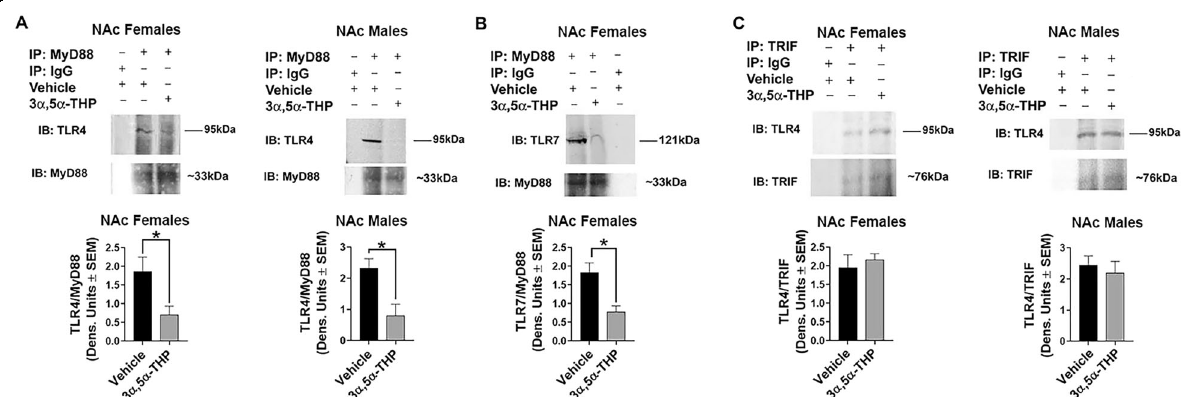
Fig. 3 3 α ,5 α -THP inhibits MyD88, but not TRIF binding to TLRs. Protein extracts obtained from the NAc of male and female P rats ( n = 3 – 4/grp) after administration of 3 α ,5 α -THP (15 mg/kg) or vehicle (45% w/v 2-hydroxypropyl- β -cyclodextrin) were immunoprecipitated (IP) with antibody to MyD88 ( A , B ) or TRIF ( C ). Proteins immunoprecipitated with MyD88 antibody were analyzed by immunoblotting (IB) with TLR4 and MyD88 antibodies ( A ) and TLR7 and MyD88 antibodies ( B ). Proteins immunoprecipitated with TRIF antibody were analyzed by immunoblotting with TLR4 and TRIF antibodies ( C ). Normal IgG was used as immunoprecipitation control. MyD88 co-precipitated with TLR4 ( A ) and TLR7 ( B ), and TRIF co-precipitated with TLR4 ( C ) but MyD88 and TRIF did not co-precipitate with normal IgG ( A – C ). A The levels of TLR4 co-precipitating with MyD88 were signi fi cantly reduced by 3 α ,5 α -THP both in males ( n = 3/grp) and females ( n = 4/grp) ( t -test, * p < 0.05). B The levels of TLR7 co-precipitating with MyD88 were also signi fi cantly reduced by 3 α ,5 α -THP in females ( t -test, * p < 0.05, n = 3/grp). C The levels of TLR4 co-precipitating with TRIF were not altered by 3 α ,5 α -THP treatment both in males ( n = 3/grp) and females ( n = 3/grp) ( t -test, p >